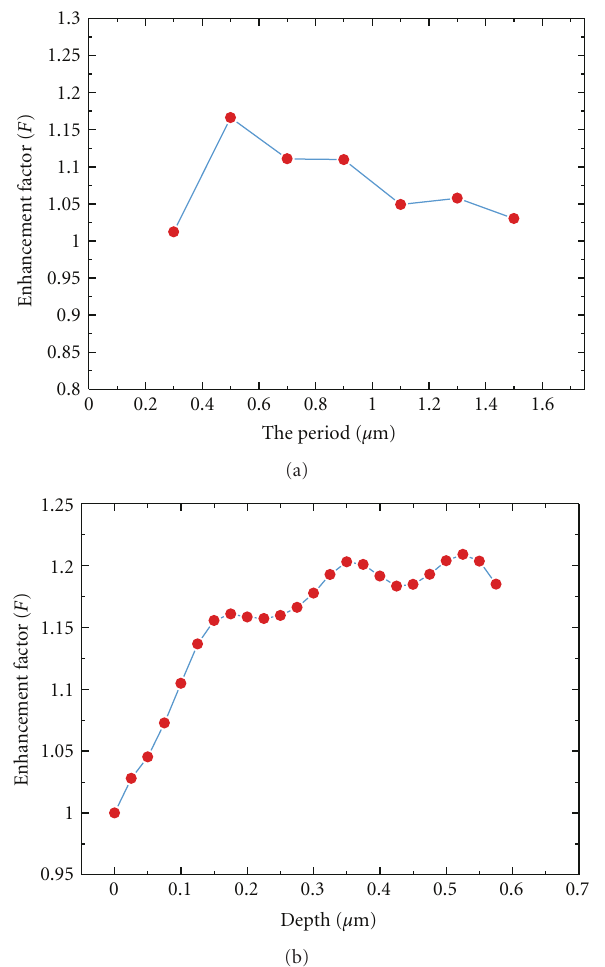
Figure 11: Enhancement of the out-coupling e ffi ciency as a func- tion (a) the period and (b) the depth of PhCs.